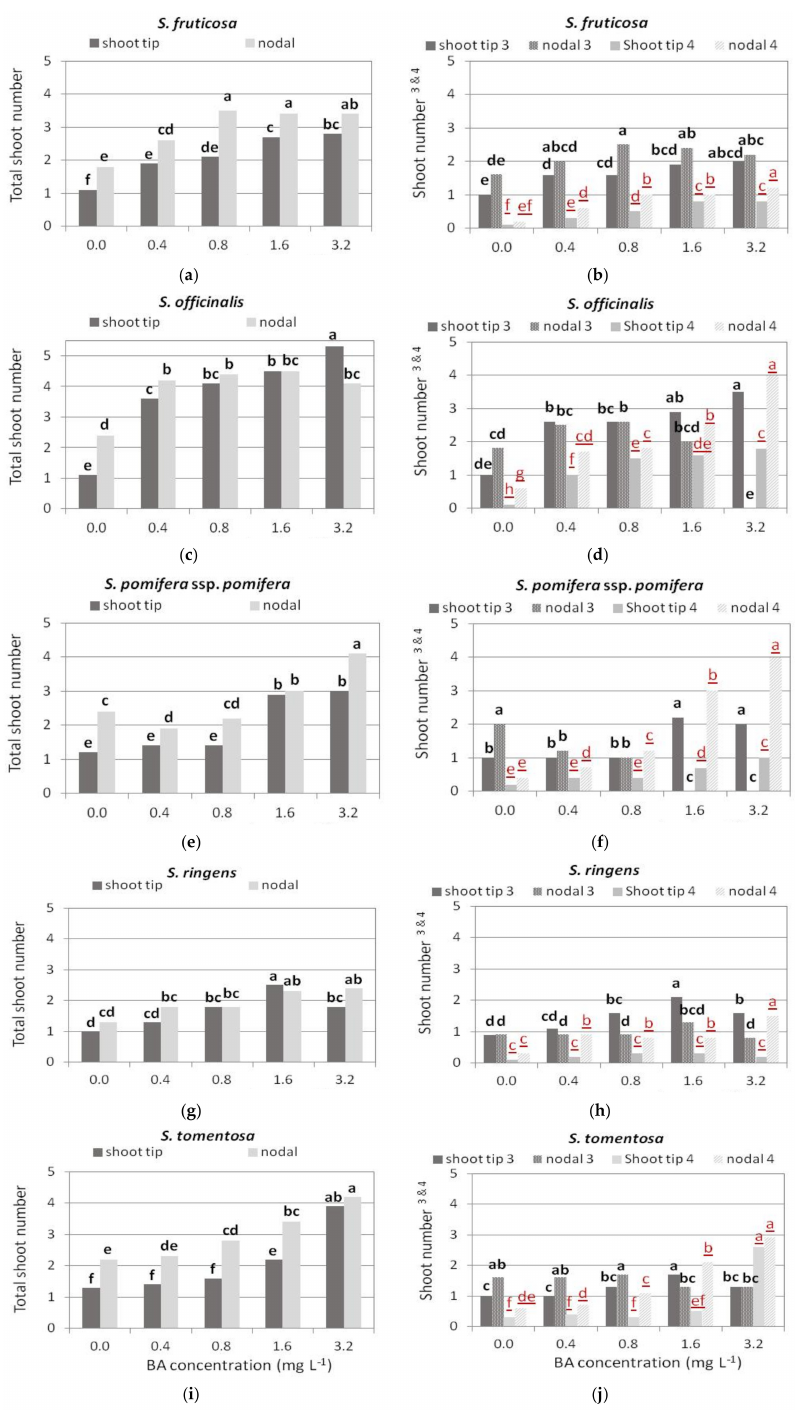
Figure 5. Effect of BA concentration on normal, hyperhydrated, and total number of shoots produced per explant of Salvia spp. shown when shoot tip or single node (nodal) explants were cultured on MS medium, either hormone free or supplemented with 0.01 mg L − 1 NAA and BA concentration marked. Response for normal and hyperhydrated shoot production was statistically analyzed separately (black bold letters and red underlined letters, respectively). Mean separation via Student’s t , p ≤ 0.05; means followed by the same letter are not significantly different at p ≤ 0.05, n = 30. Normal shoots per explant. Hyperhydrated shoots per